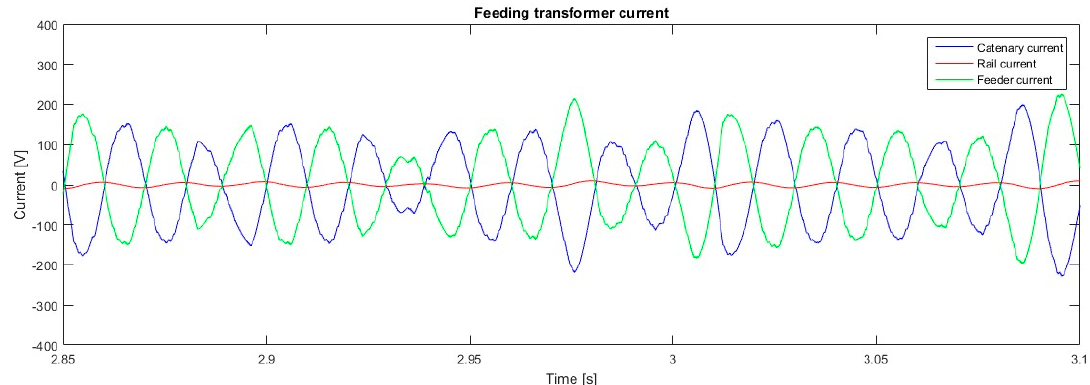
Figure 14. Current measured on the feeding transformer with the charging stations and no trains on the track.